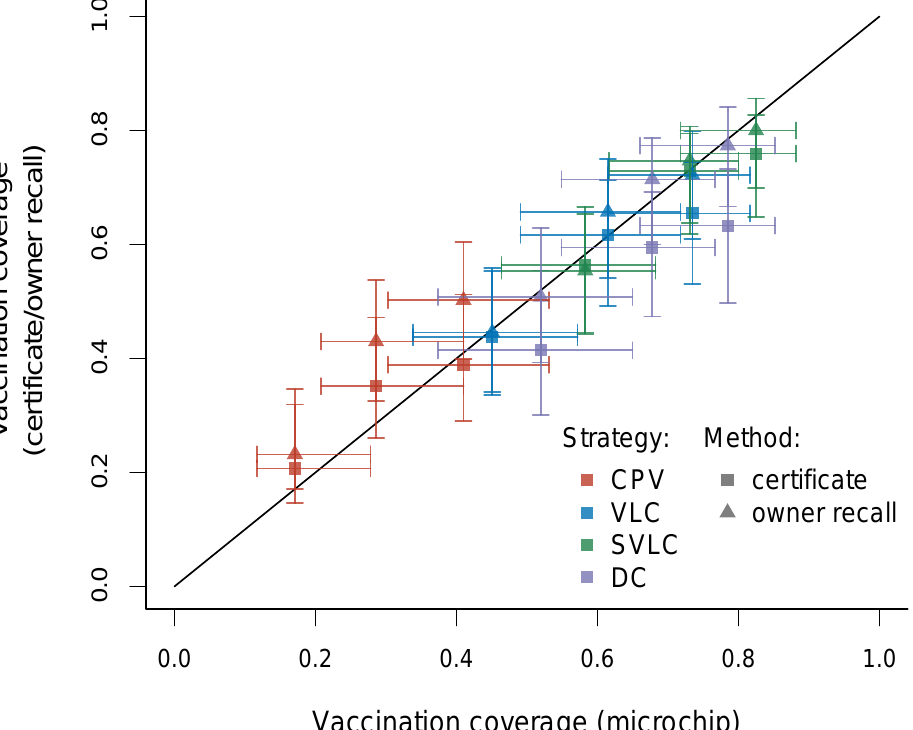
Figure 4. Coverage estimates according to different methods of measuring coverage. Generalized linear mixed model (GLMM) estimates in each of the twelve study districts under each of the three coverage estimation methods at 11 months after the main vaccination campaign. 95% confidence intervals estimated using 1000 bootstrap samples from the fitted GLMMs are included for the estimates obtained using certificates and owner recall (vertical intervals) and using the gold standard microchip method (horizontal intervals). CPV = centralized pulsed vaccination, VLC = village-level continuous decentralized vaccination, SVLC = sub-village level continuous decentralized vaccination, DC = discretionary continuous decentralized